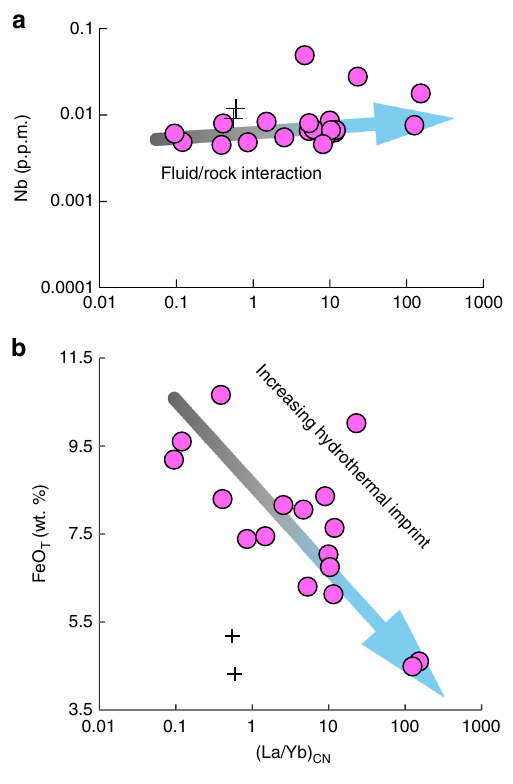
Fig. 3 Nb and FeO T contents versus (La/Yb) CN ratio in North Aït Ahmane serpentinites. a Non-correlation between (La/Yb) CN ratio and Nb content attests to the hydrothermal origin of LREE enrichment. b Negative correlation between FeO T and (La/Yb) CN highlights the relationship between black smoker-type hydrothermalism and iron leaching in serpentinites involved in magnetite veins formation. Black crosses are antigorite veins. La and Yb are normalized to chondrite 66